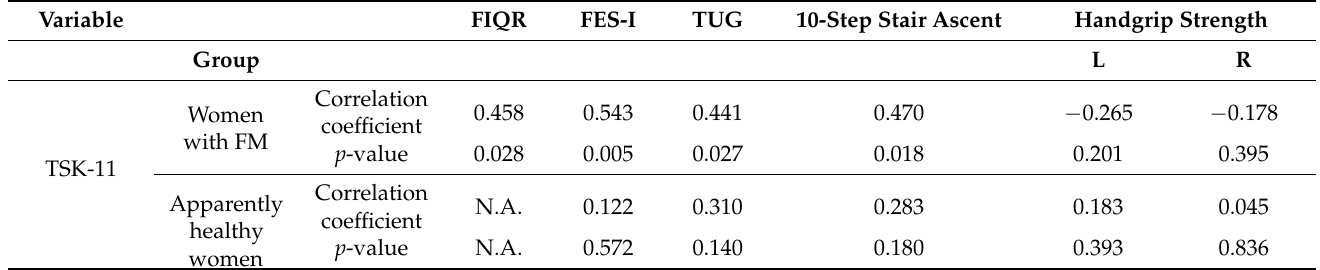
Table 2. Relationship between kinesiophobia, impact of FM, fear of falling, and physical fitness